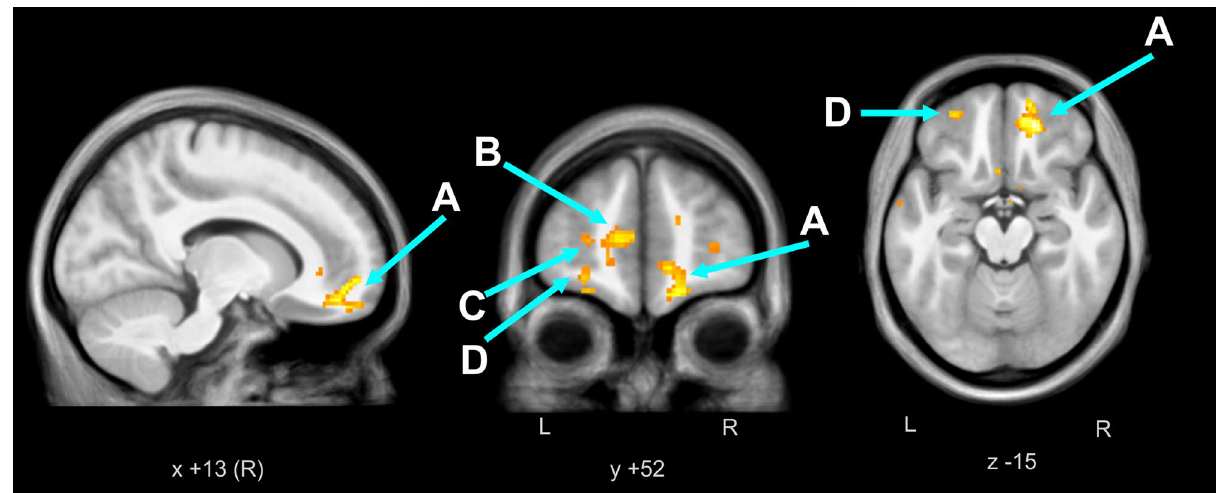
Figure 1. ALFF higher in pediatric HIV vs. Control. In pediatric HIV patients (n = 11) compared to controls (n = 16), we observed significantly higher cluster FWE-corrected p < 0.05 and uncorrected p < 0.05 values for the ALFF resting state fMRI activity in bilateral cerebral white matter. The regional activity was overlaid on anatomical mean of all 27 subjects’ T 1 images. ( A ) Right cerebral white matter/right medial prefrontal cortex, ( B ) left cerebral white matter/left prefrontal cortex, ( C ) left cerebral white matter, ( D ) left cerebral white